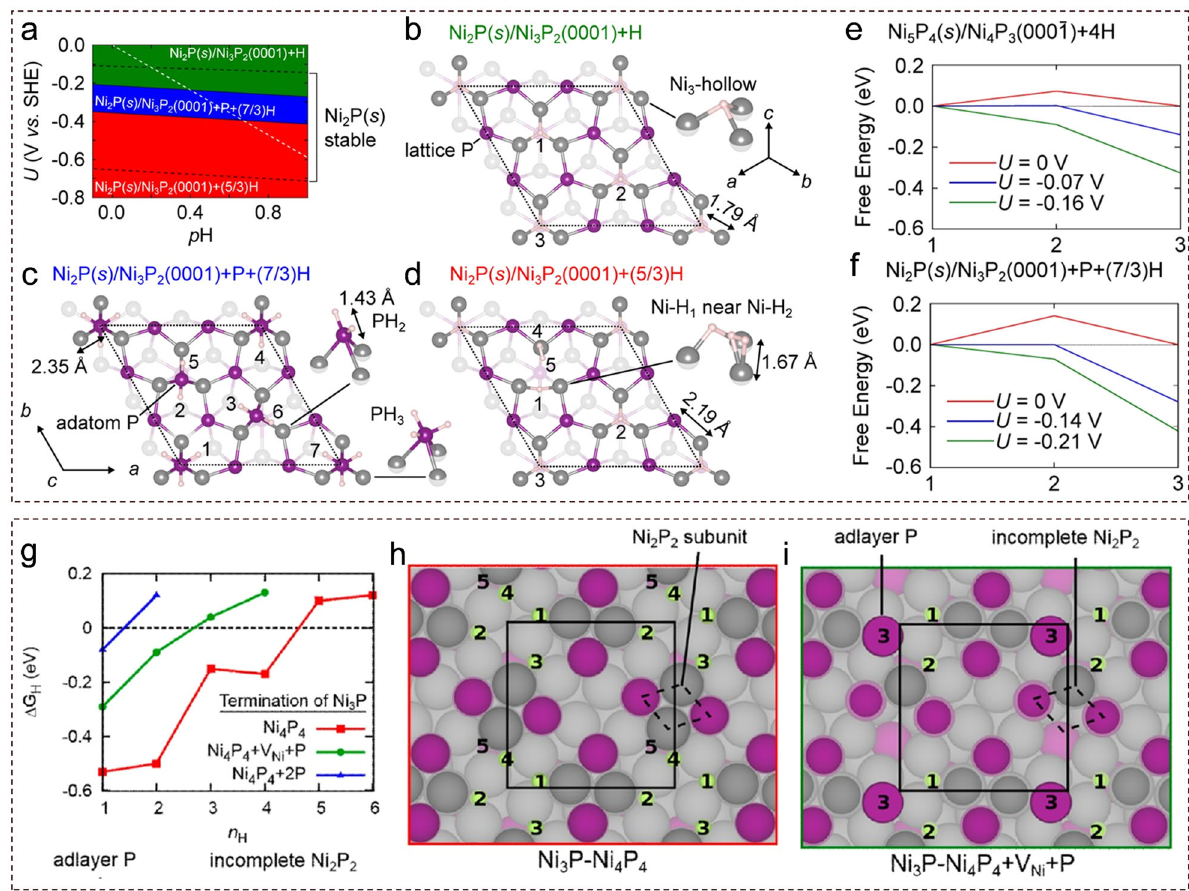
Fig. 12 HER on transition metal phosphides. a Surface phase diagram of Ni 2 P(0001). b – d The evolution of the surface through adsorption − desorption equilibrium of P. P dissolves off the surface as phosphates. e , f Free energy of intermediates in the HER for Ni Ni 5 P 4 (000 1 ), respectively ( a – f are reproduced with permission from ref. 342 , Copyright © American Chemical Society 2017). g The H* adsorption free energy as a function of H* coverage ( n H ) for the three stable Ni 3 P(001) surfaces on h Ni 3 P( s )/Ni 4 P 4 (left) and i Ni 3 P( s )/Ni 4 P 4 + V Ni + P (right) (reproduced with permission from ref. 351 , Copyright © American Chemical Society